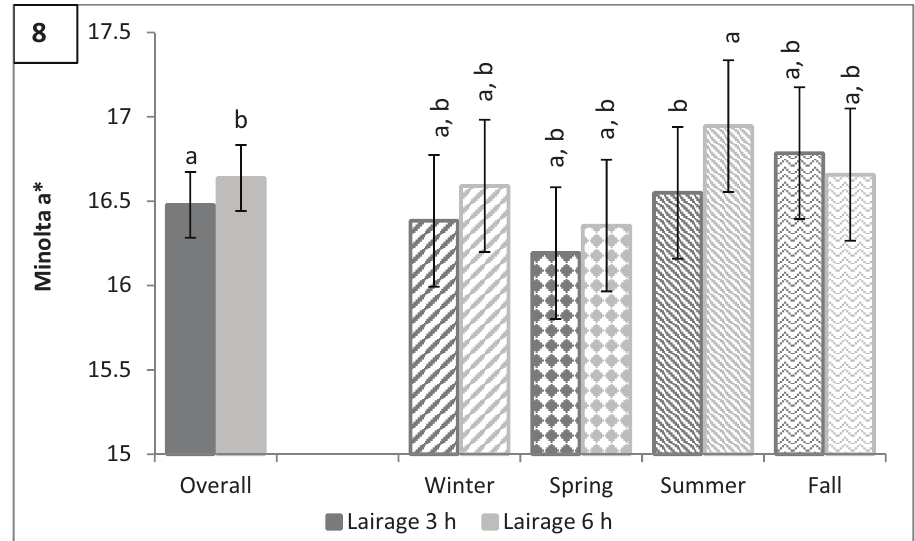
Figure 8. Minolta a* by lairage (P < 0.0001) and by season × lairage duration (P < 0.0001). Values with different letters differ by P <